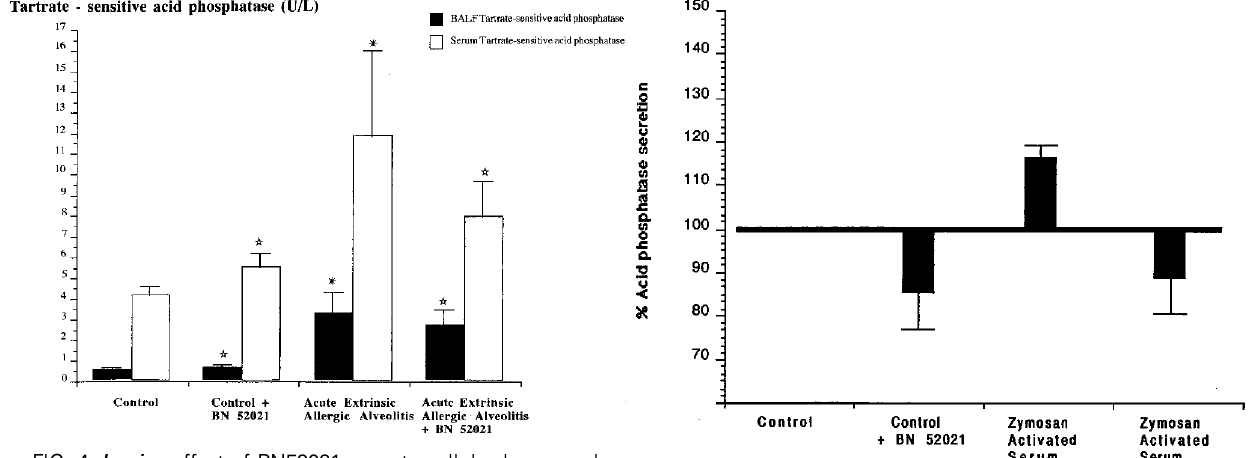
FIG. 4. In vivo effect of BN52021 on extracellular lysosomal enzymes. Data are mean ± SD of six guinea pigs/group and were analysed by one-way analysis of variance and multiple mean comparison test. Asterisks ( w ) represent significant differences ( P < 0.05) with respect to control group and stars ( q ) significant differences ( P < 0.05) with respect to the acute EAA group.